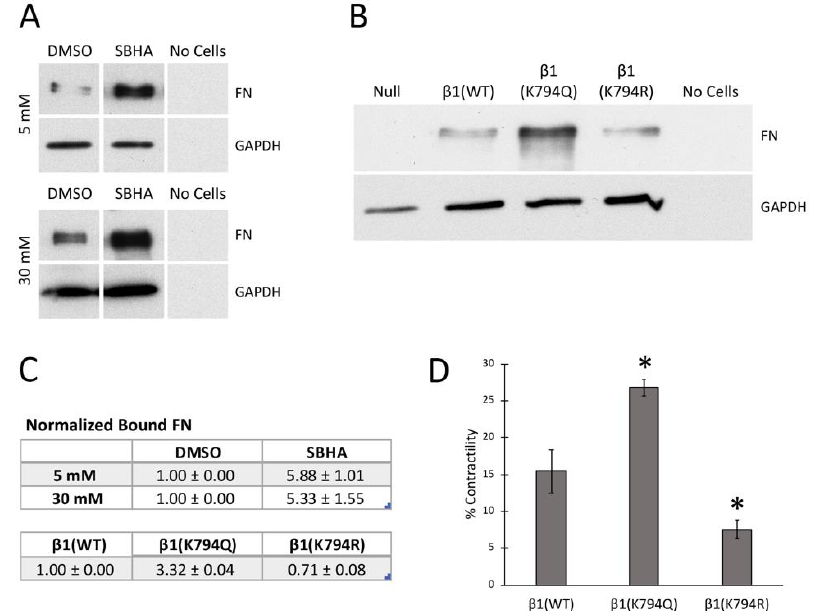
Figure 6. Acetylation promotes integrin activation. ( A ) Mesangial cells grown in 5 mM (top) or 30 mM (bottom) glucose and SBHA or DMSO and ( B ) GD25 cells expressing various integrins were incubated with FN in suspension. Cell-bound FN was detected by immunoblotting with HFN7.1 anti-human FN antibody and GAPDH (as loading control). Representative blots are shown, and FN lanes in 5 and 30 mM panels are from the same blot and exposure time. ( C ) Average fold-changes in bound FN (± SEM) were calculated from three independent experiments for the conditions in ( A , B ). p < 0.02 for each condition compared to control. ( D ) Changes in matrix area with contraction by the indicated cells within a fibrin-FN matrix were averaged for three independent experiments and data are expressed as the mean ± SEM. * p < 0.05 relative to β 1(WT) area.